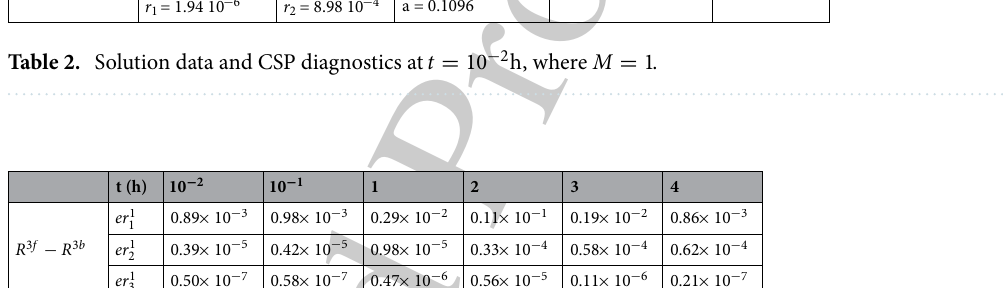
Table 3. Relative error in approximating ( R 3 f − R 3 b ) at indicative points along the M = 1 period: via the QSSA expression in Eq. (5) ( er 1 1 ), the more accurate expression in Eq. (15) ( er 1 2 ) and the CSP expression in Eq. (35) ( er 1 3